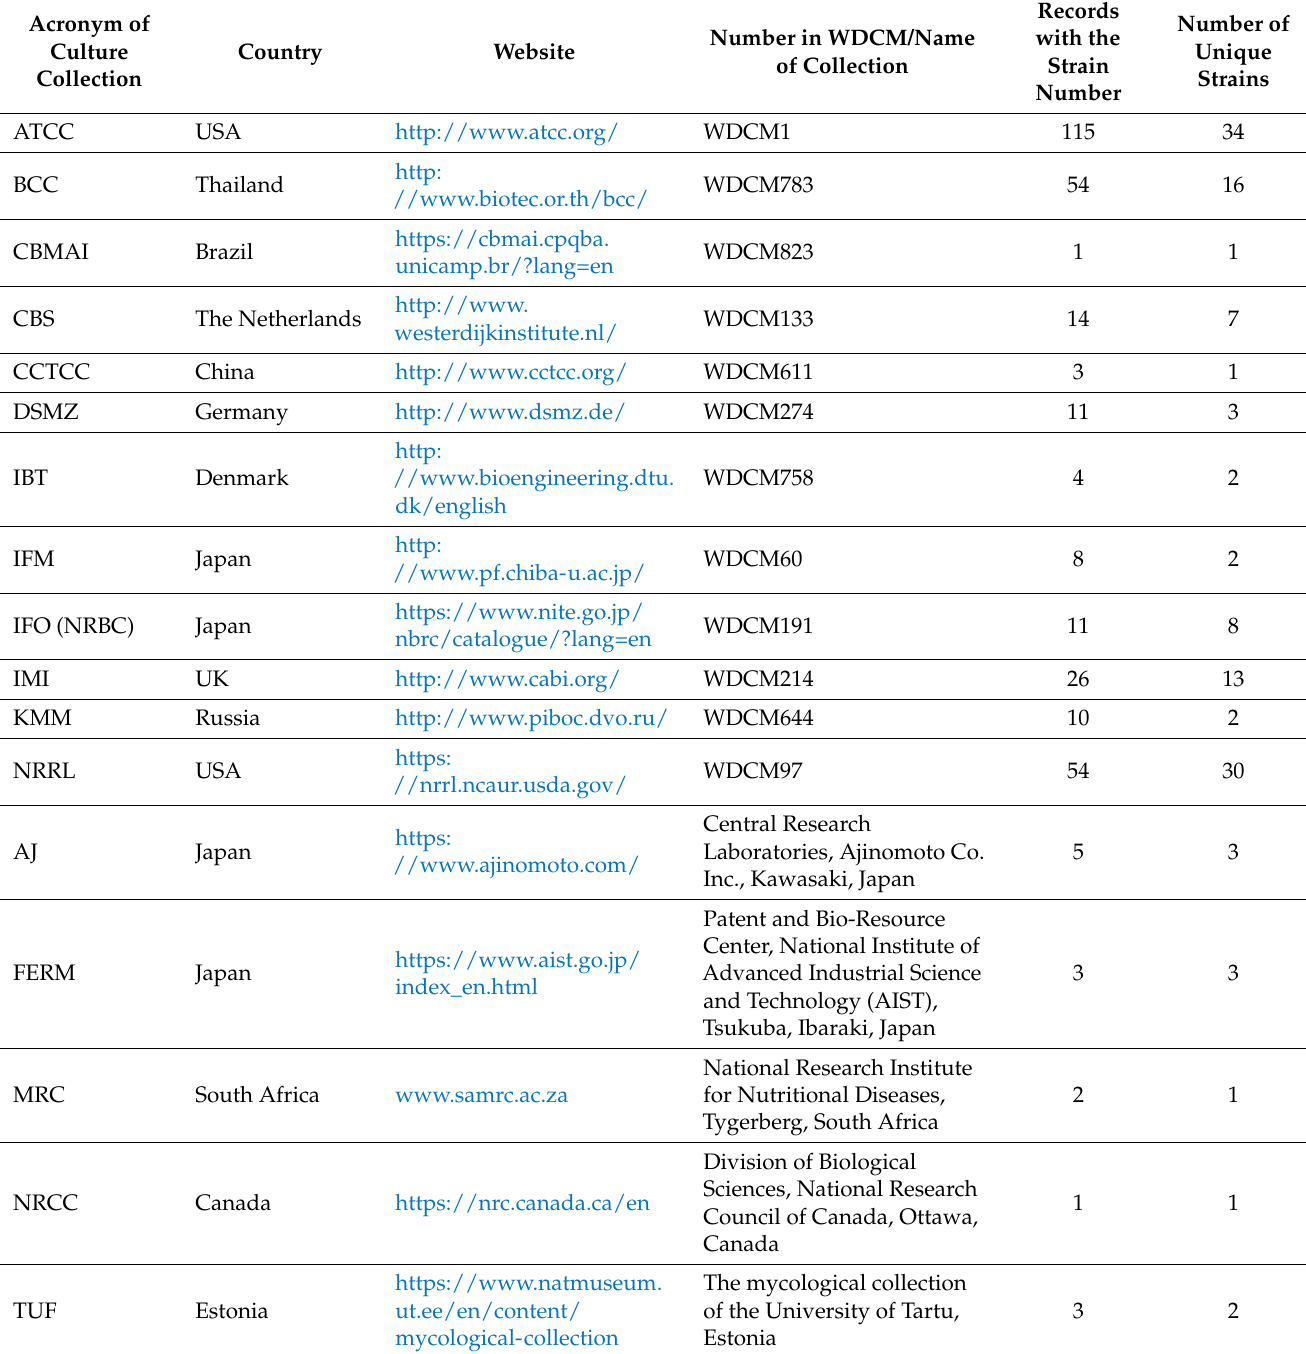
Table 7. Strains in Metabolites of Fungi database (on 26 April 2022).